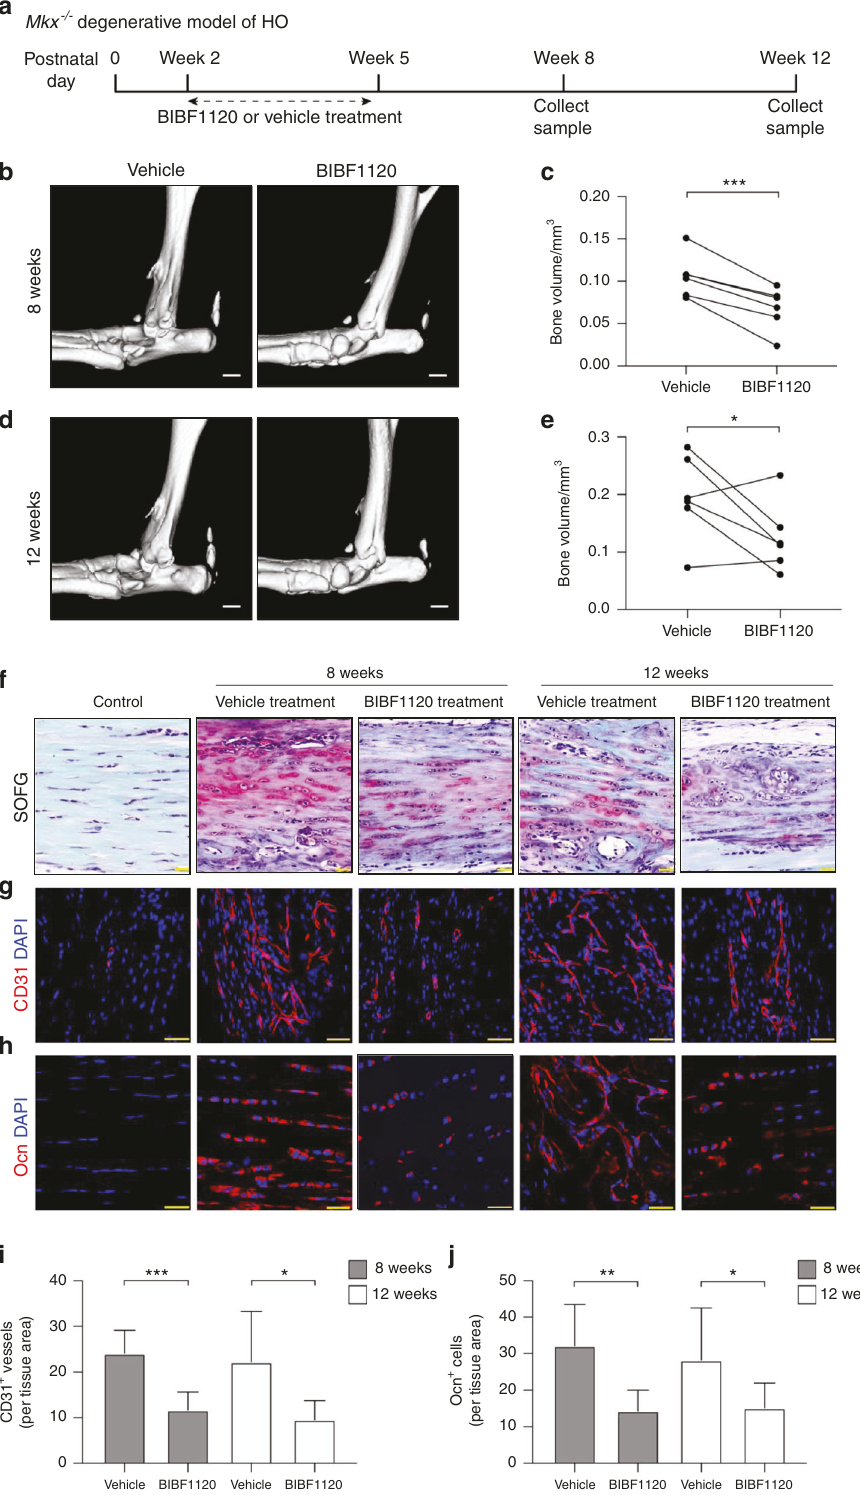
Fig. 6 The angiogenesis inhibitor BIBF1120 attenuates heterotopic bone formation in the Mkx − / − degenerative model of HO. a Schematic illustration of the treatment and sample collection work fl ow. b – e Micro-CT images of the Achilles tendons of 8-week-old ( b ) and 12-week-old ( d ) Mkx − / − mice treated with BIBF1120 or vehicle. Scale bar, 1 mm. Quantitative analysis of the heterotopic bone volumes of the Achilles tendons of 8-week-old ( c ) and 12-week-old ( e ) Mkx − / − mice. f Safranin O-Fast green staining of the Achilles tendons of normal, 8-week-old and 12-week-old Mkx − / − mice. Scale bar, 50 μ m. g Immunostaining of CD31 + (red) vessels. Scale bar, 50 μ m. h Immunostaining of Ocn + (red) cells in ectopic bone marrow. Scale bar, 25 μ m. i , j Quanti fi cation of CD31 + ( i ) vessels and Ocn + ( j ) cells. All data are shown as the mean ± s.d. n = 6 per group. Statistical test: student t test. * P < 0.05; ** P < 0.01; *** P <